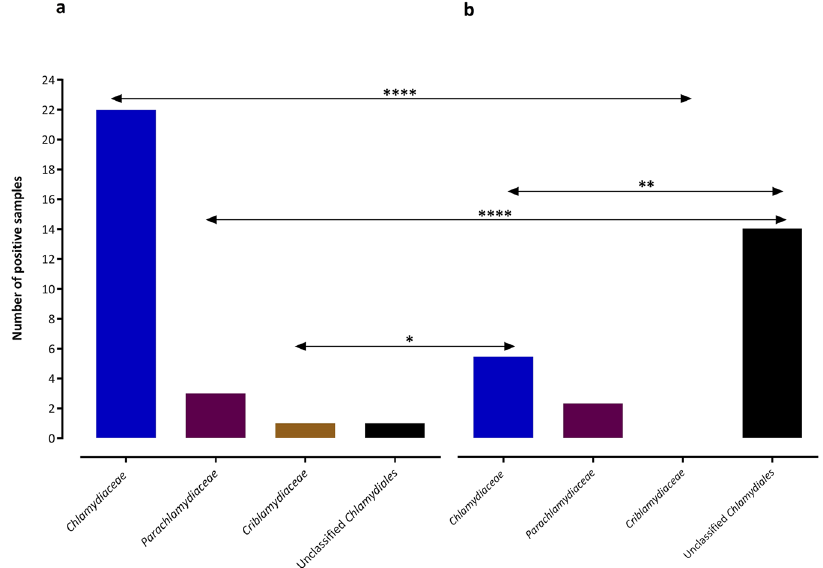
Figure 5. Abundance of 16 S rRNA gene sequences in the ocular samples taken from Al Qadarif-Sudan at the family-level in the Chlamydiae based on phylogenetic analysis. ( a ) Sequences derived from samples of children. ( b ) Sequences derived from samples of adults. The statistical significance is indicated as follows: * p < 0.05, ** p < 0.01, and **** p <